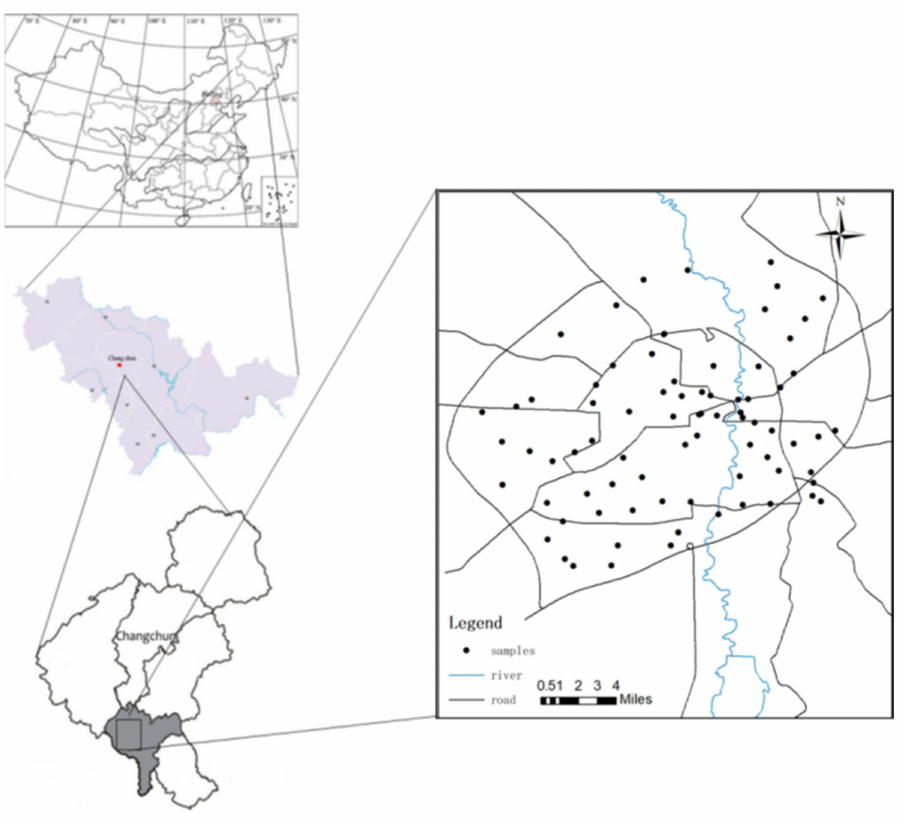
Figure 2. Layout of the sampling